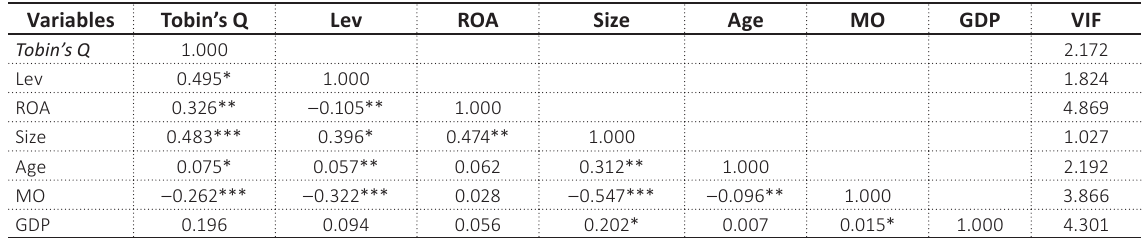
Table 3. Correlation matrix and variance inflation